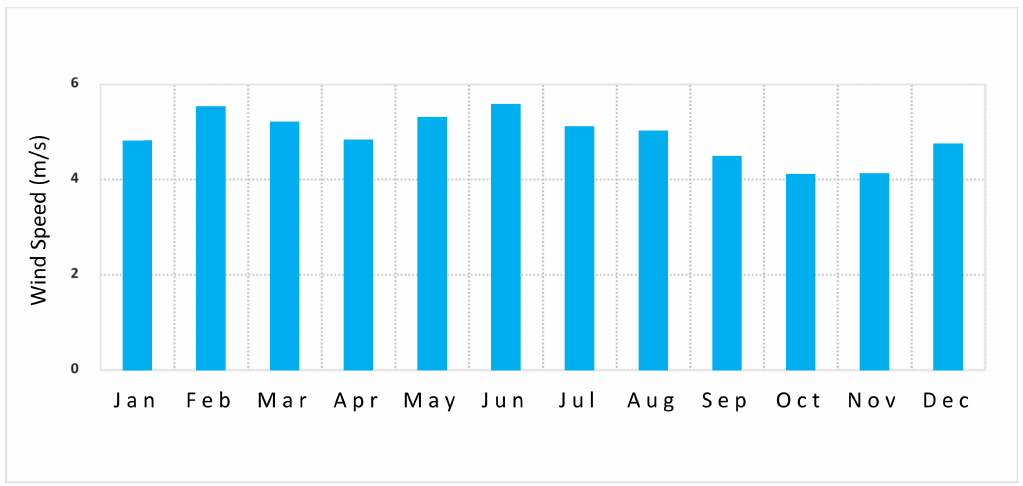
Figure 3. Monthly average speed in